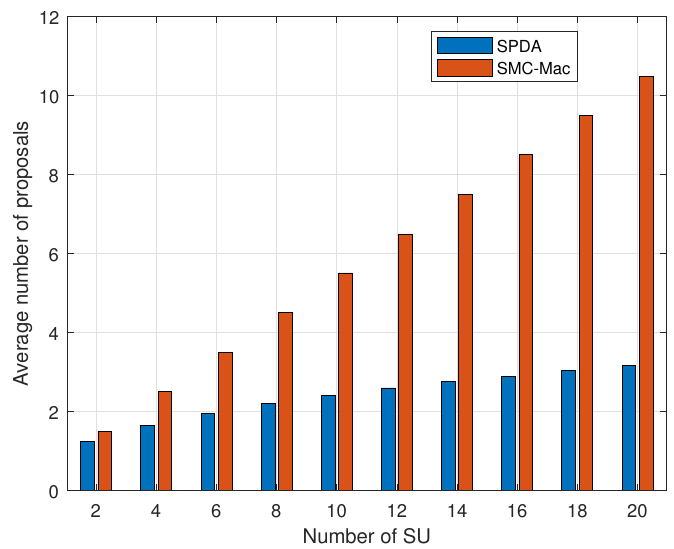
Figure 9. Average number of proposal with a varying number of SUs in cognitive radio networks (CRNs).